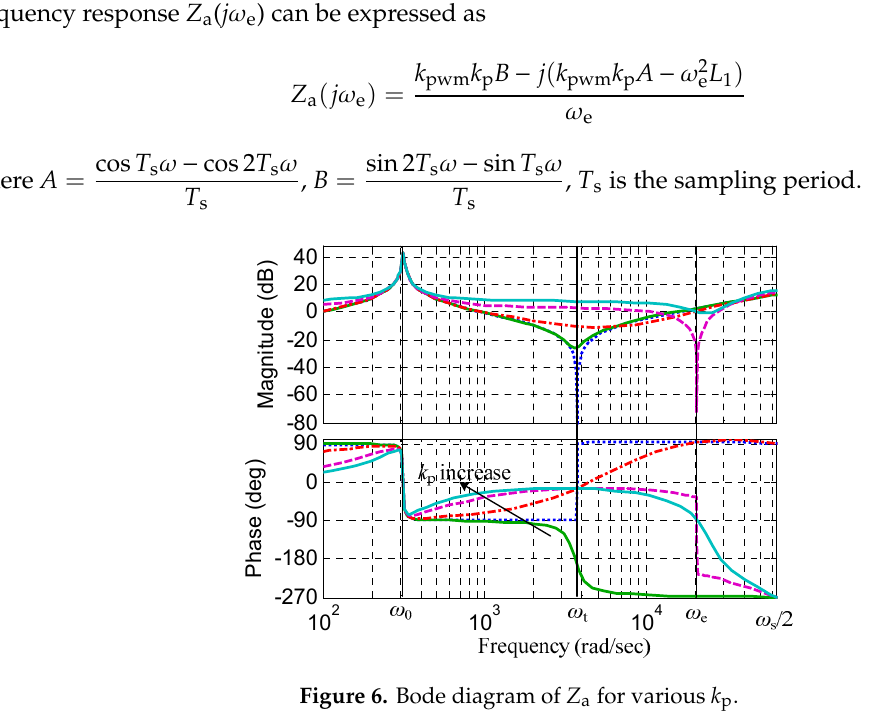
Figure 6. Bode diagram of Z a for various k p .